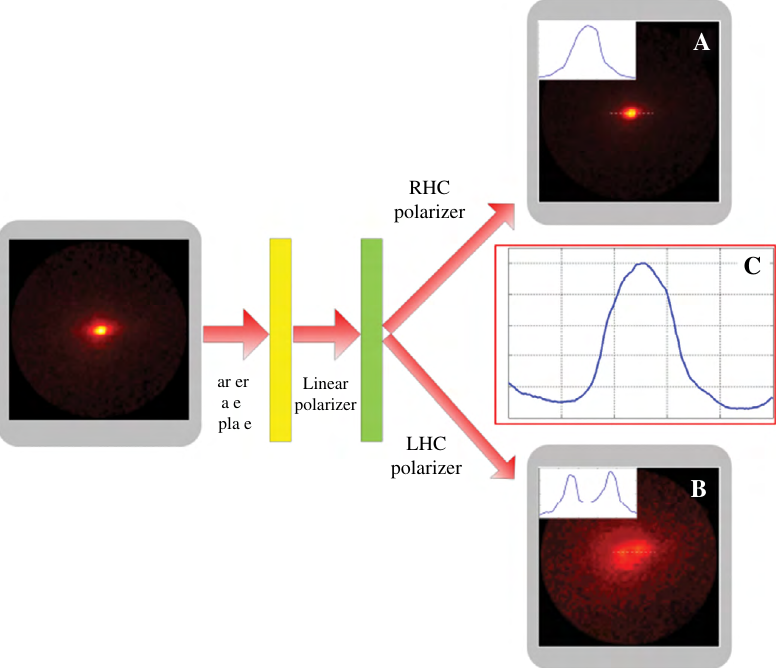
Figure 10 Methods for measuring the circular polarization extinction ratio of the fluorescence emission. The radiation emissions filtered by (A) a RHC polarizer and (B) LHC polarizer. (C) Line-scan of the circular polarization extinction ratio. Adapted from Ref. [34].